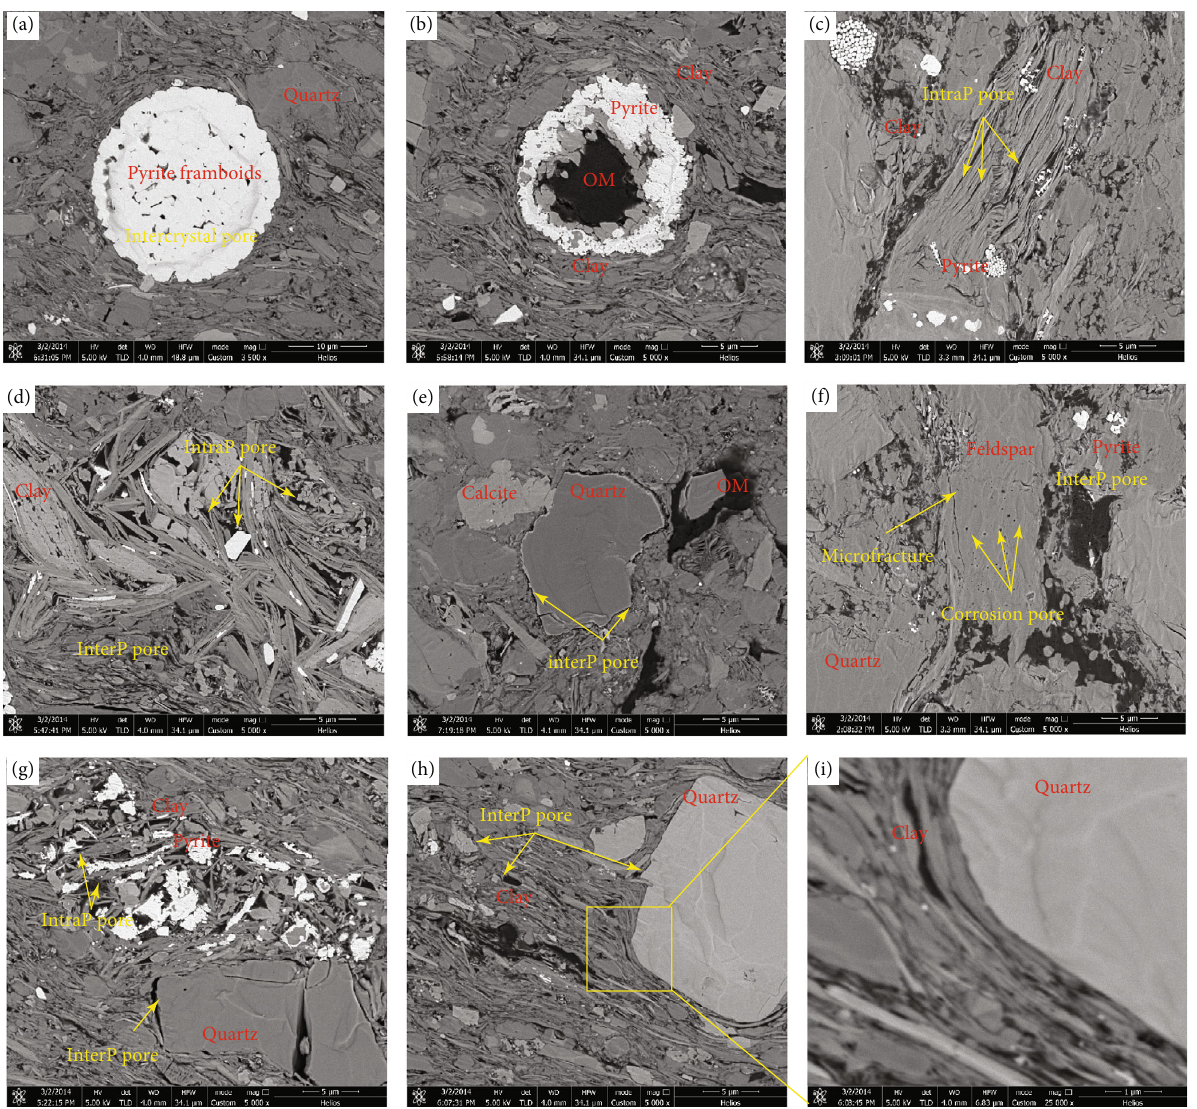
Figure 6: The SEM images of inorganic matter pores from MS and SM lithofacies Chang 7 lacustrine sample. (a) Single pyrite framboid which consists of euhedral crystals (sample ID: YY4-2, 1532.19m). (b) The InterP pores of toroidal pyrite are commonly observed in the shale samples fi lled with OMs (sample ID: YY5-3, 1437.9m). (c) Clay mineral intergranular pores showing narrow strip